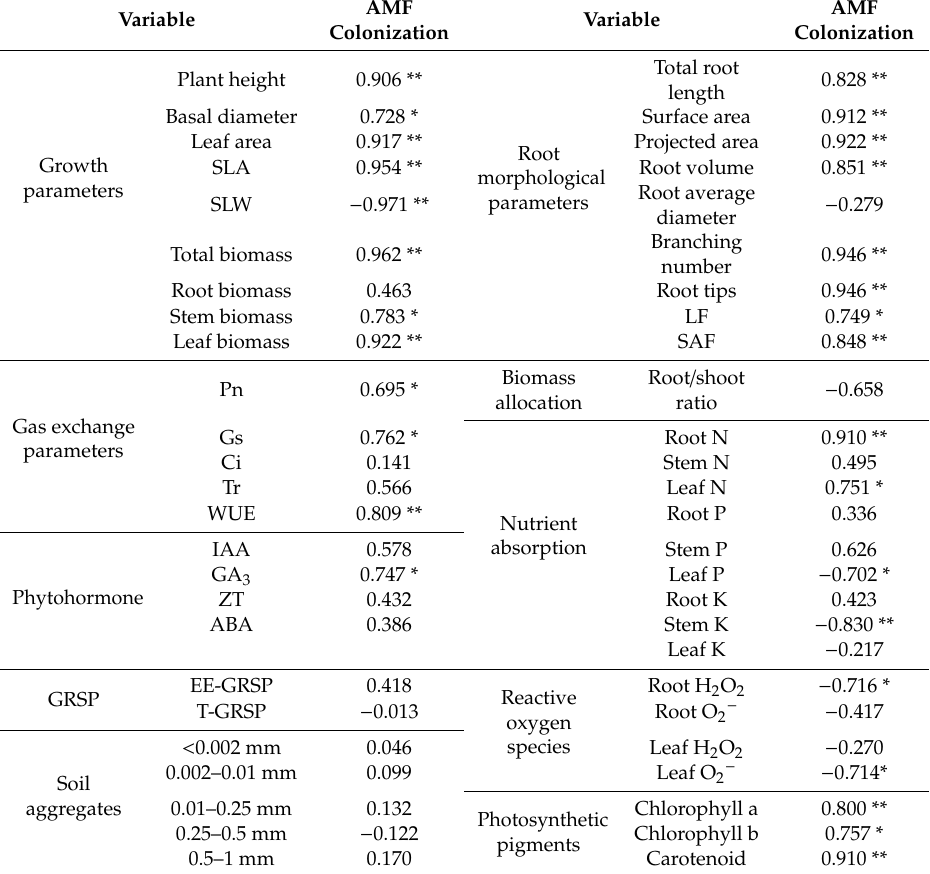
Table 5. Pearson correlation coe ffi cients between AMF colonization and the other